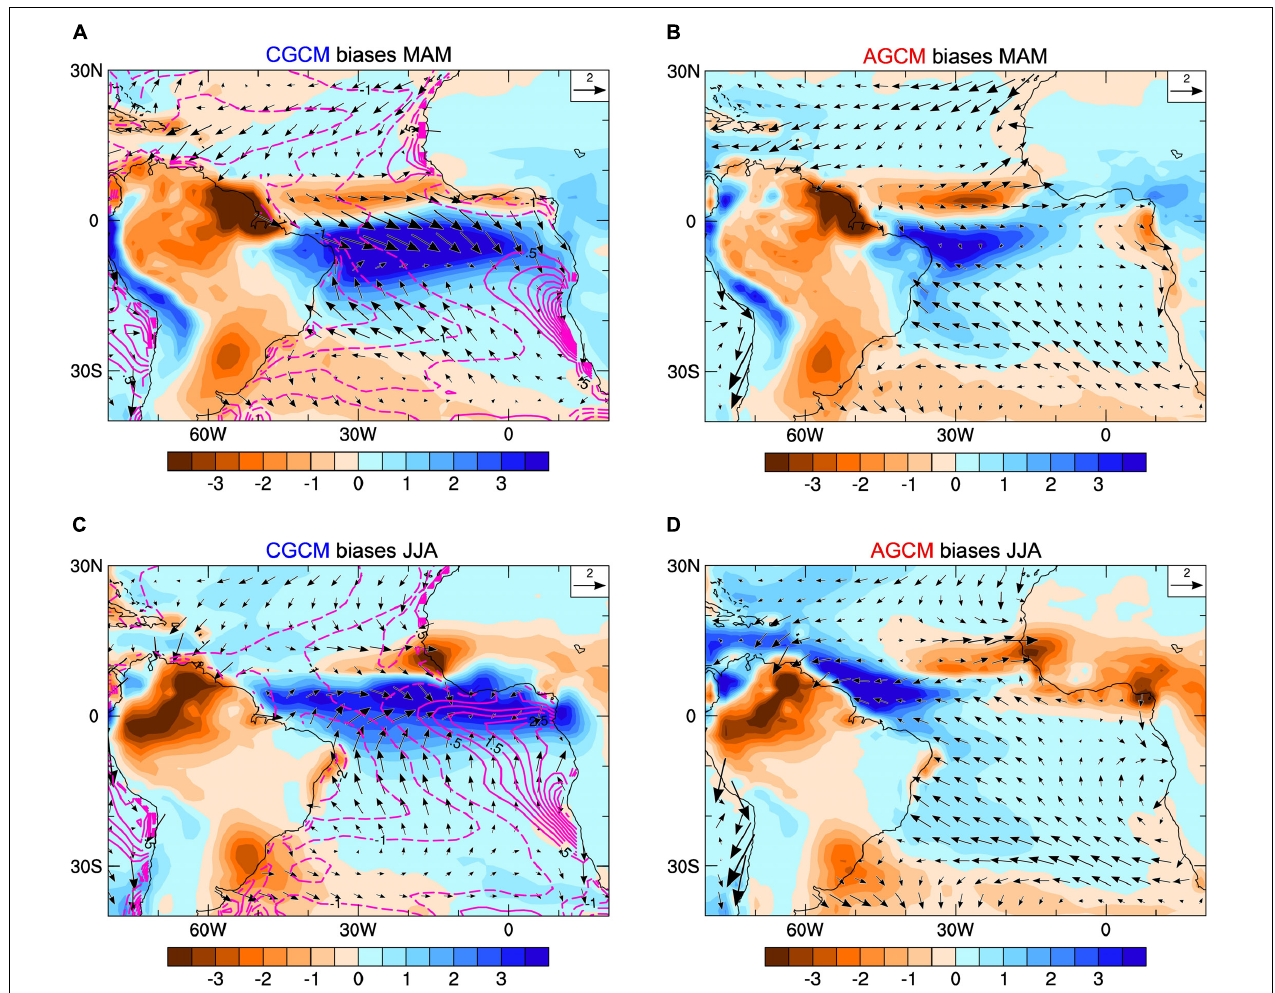
FIGURE 9 | Biases of precipitation (shading; mm day − 1 ), surface winds (vectors), and SST (contours; K) for an ensemble of CMIP5 models. Panels show the biases for (A) control experiment in March–April–May using coupled general circulation models (CGCM), (B) experiment AMIP [atmospheric general circulation models (AGCM) only] in MAM, (C) control experiment in June–July–August, and (D) experiment AMIP in JJA. The reference data sets are the Global Precipitation Climatology Project (Adler et al., 2003) for precipitation, the European Centre for Medium-Range Weather Forecasts Interim Reanalysis (Dee et al., 2011) for surface winds, and Reynolds optimally interpolated dataset (Reynolds et al., 2002) for